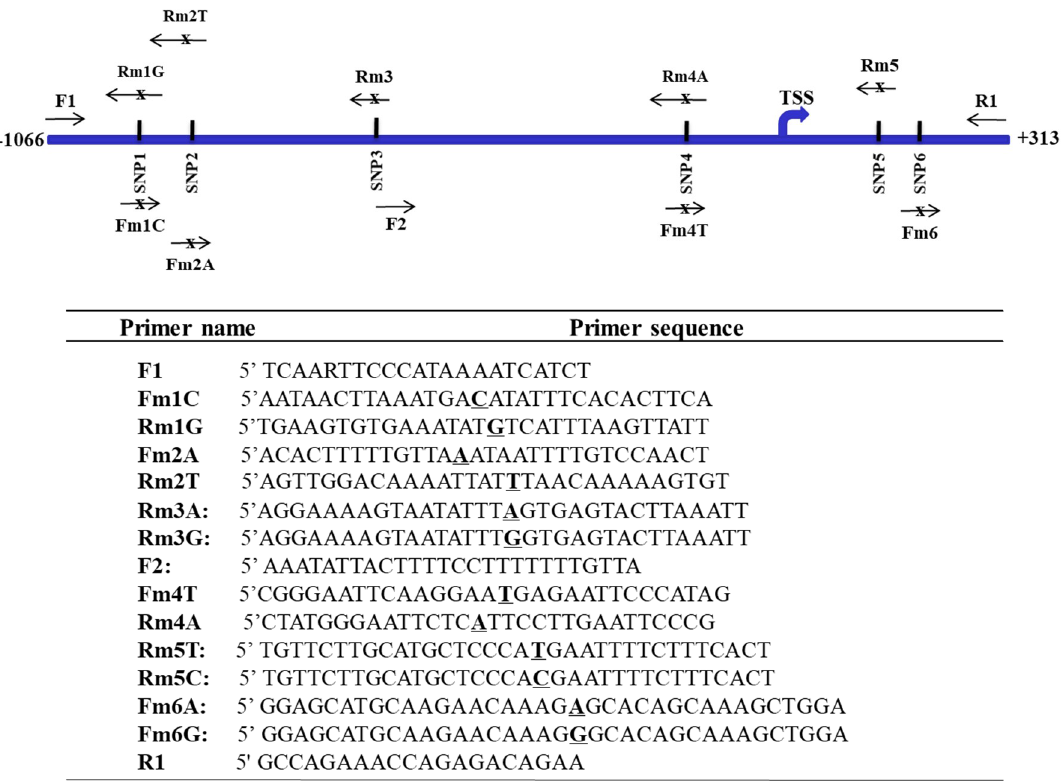
Figure 2. Primers for the generation of the different haplotypes of single nucleotide polymorphisms (SNPs) at the FAT10 promoter. Top: Schematic representation of the location of the various primers. Bottom: Table showing the sequence of the various primers. Bold underlined letters represent the SNP allele.